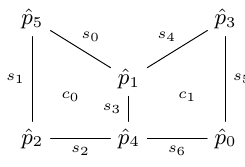
Figure 5. EXAMPLE: Valid geo-spatio-temporal segment-polytope complex C for two neighboring geo-spatio-temporal segment-polytopes c 0 , c 1 ∈ C with s 2 , s 0 ∈ c 0 and s 6 , s 4 ∈ c 1 and s 2 , s 6 as